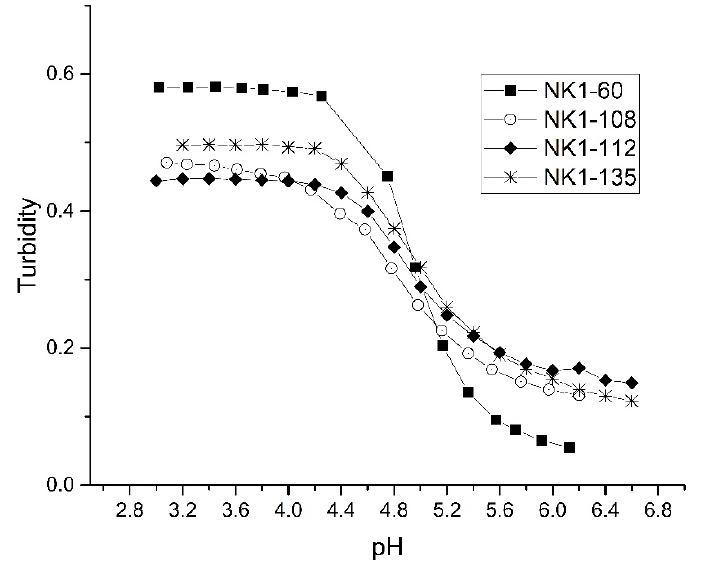
Figure 7. pH response profiles of four PVA membranes prepared from NK 1-60, NK 1-108, NK 1-112, and NK 1-135 polymer particles (70% NIPA, 10% MAA, 10% NTBA, 10% MBA).